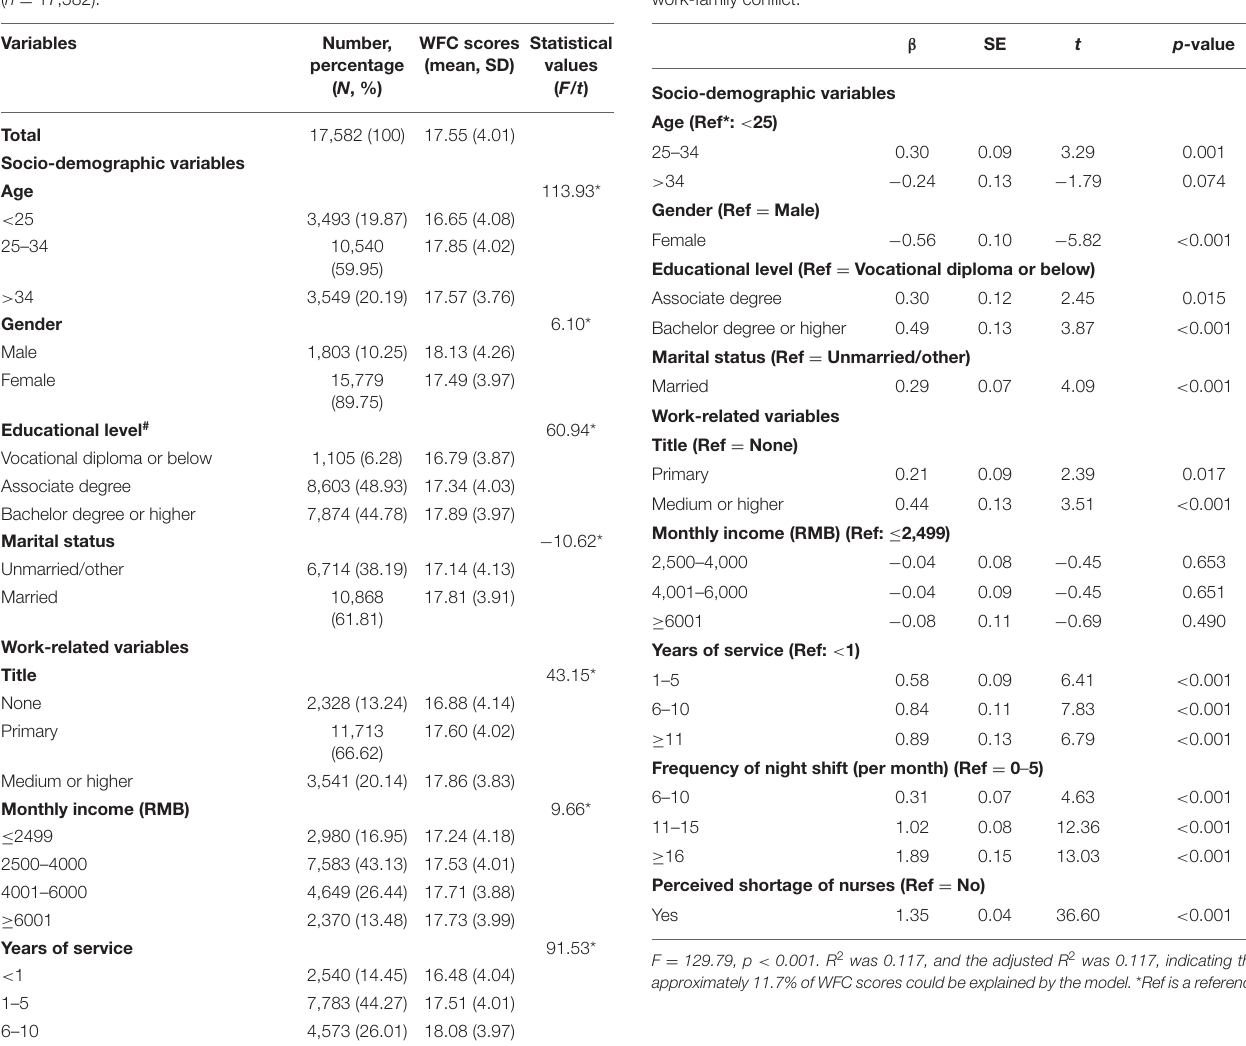
TABLE 2 | Generalized linear regression examining factors associated with work-family